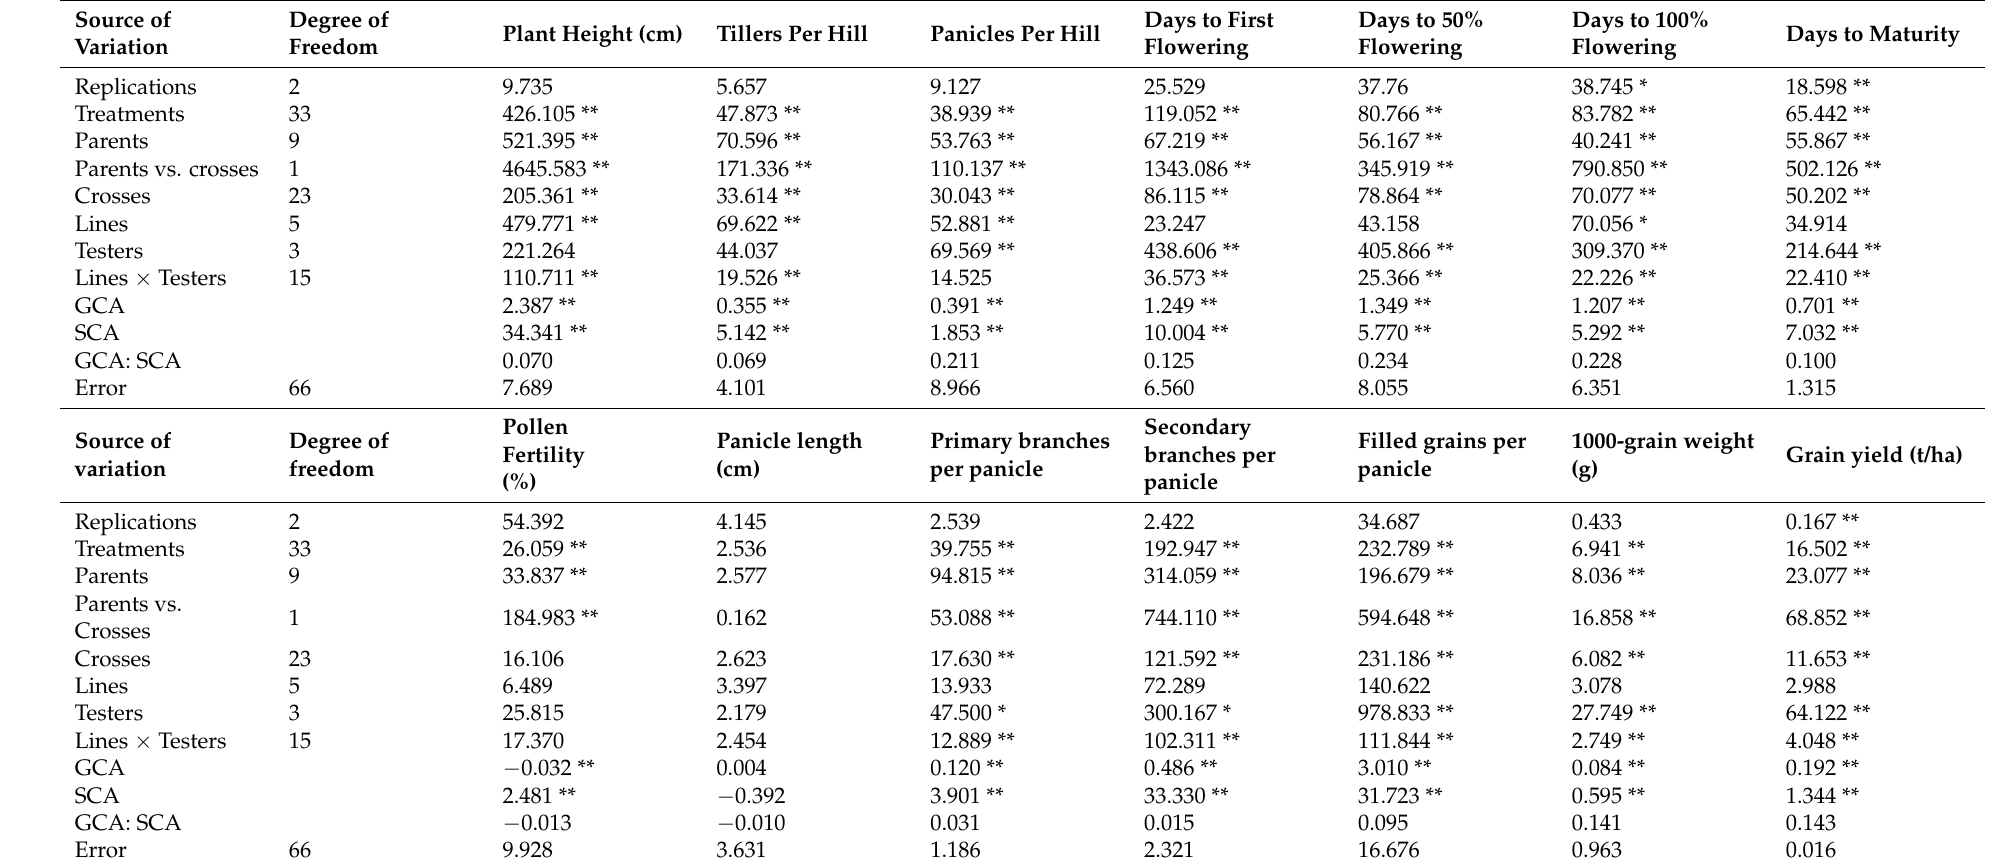
Table 2. Analysis of variance of combining ability for yield and its contributing